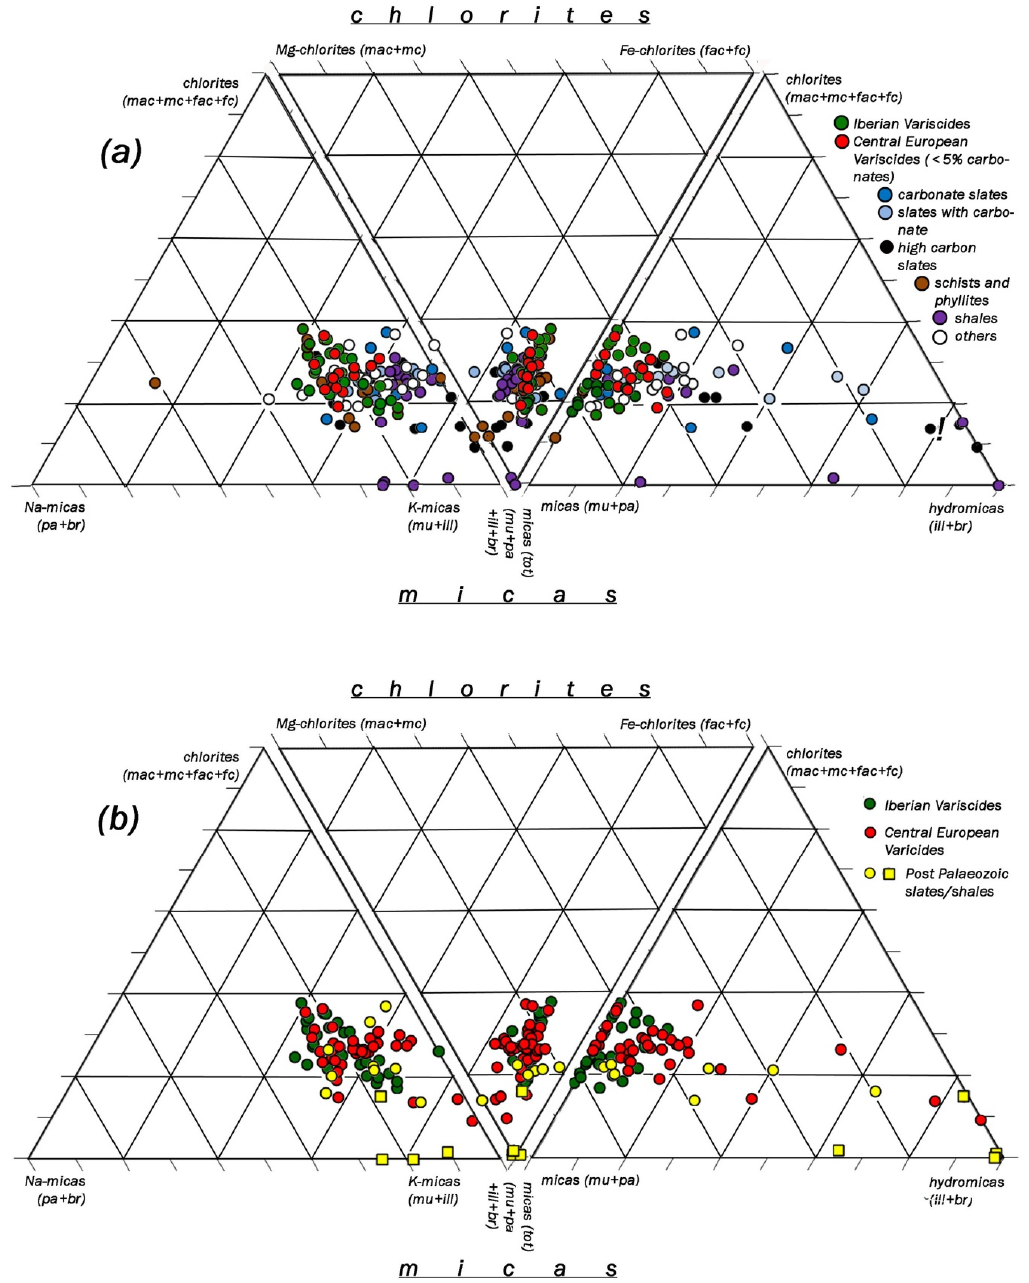
Figure 10. Phyllosilicates as calculated by slatecalculation ( a ) Types of phyllosilicates; ( b ) selection of different deposits.